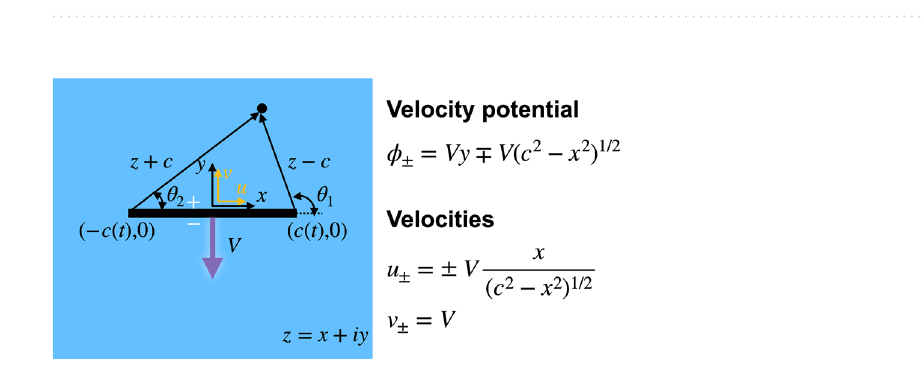
Figure 1. (a) Various locomoting animals: A bird flies with flapping wings, an animal dives into water, and an aquatic animal swims with flapping fins or fluke. (b) Simplified and analogous motions of the thin appendages of animals.